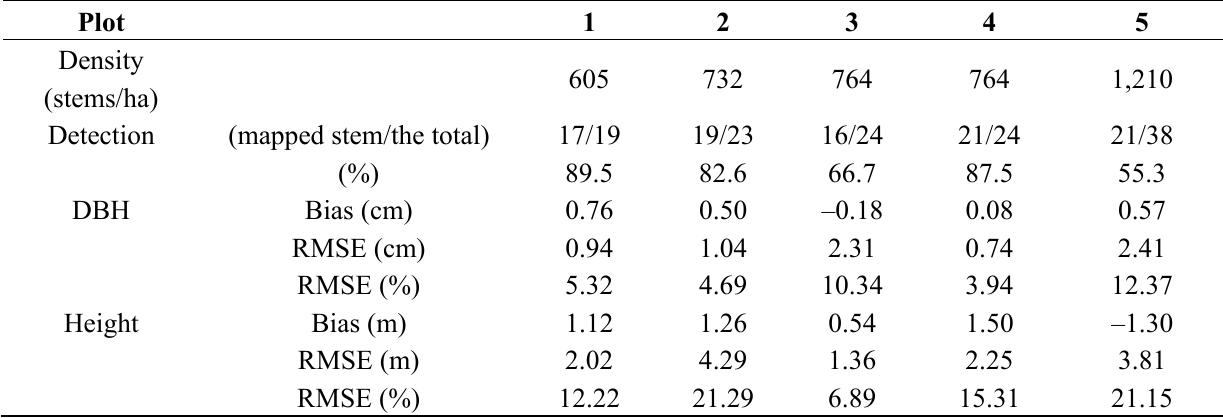
Table 4. The results of stem mapping using the single-scan